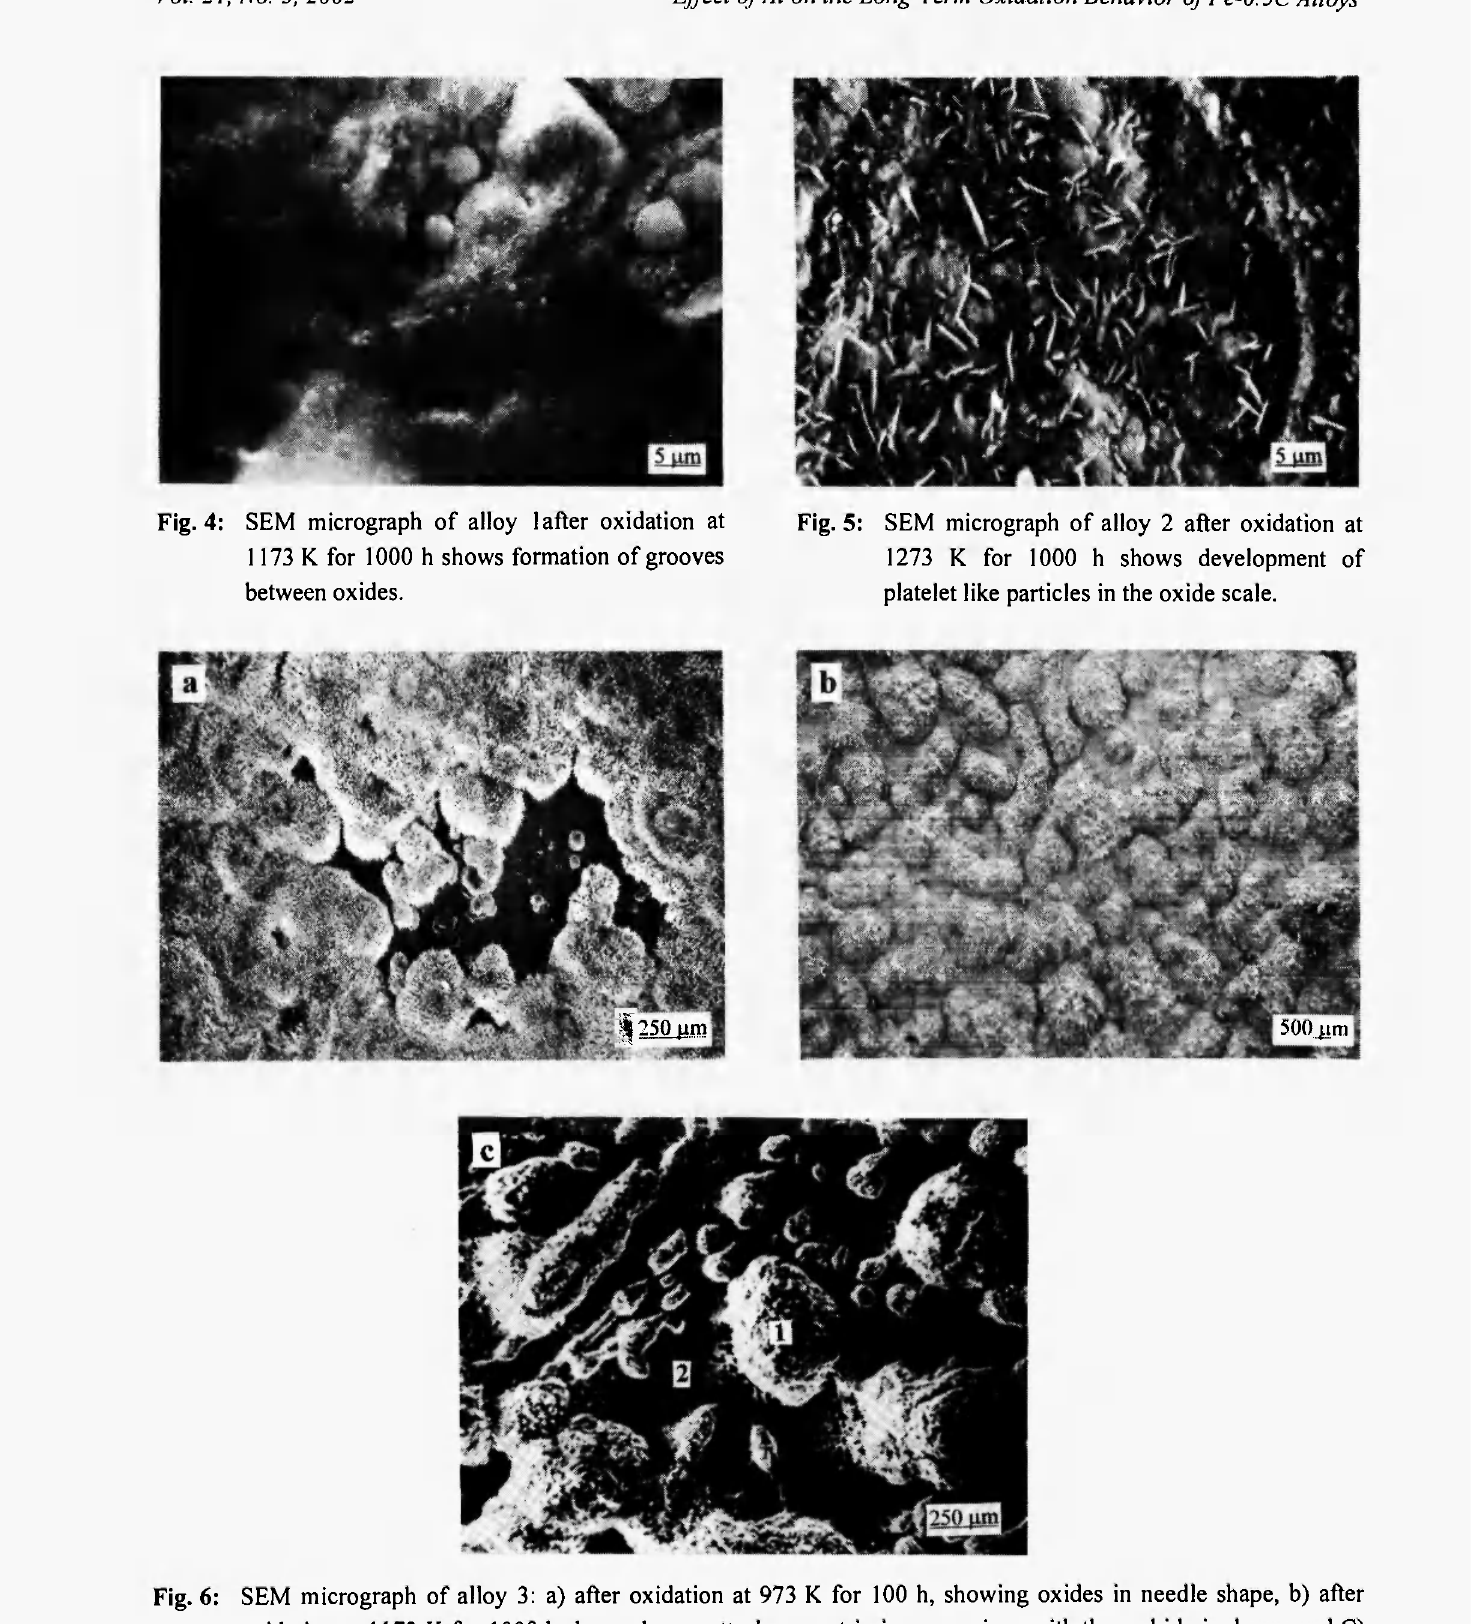
Fig. 6: SEM micrograph of alloy 3: a) after oxidation at 973 Κ for 100 h, showing oxides in needle shape, b) after oxidation at 1173 Κ for 1000 h shows deeper attack on matrix in comparison with the carbide is shown and C) after oxidation at 1273 Κ for 1000 h showing formation of oxide nodules on the